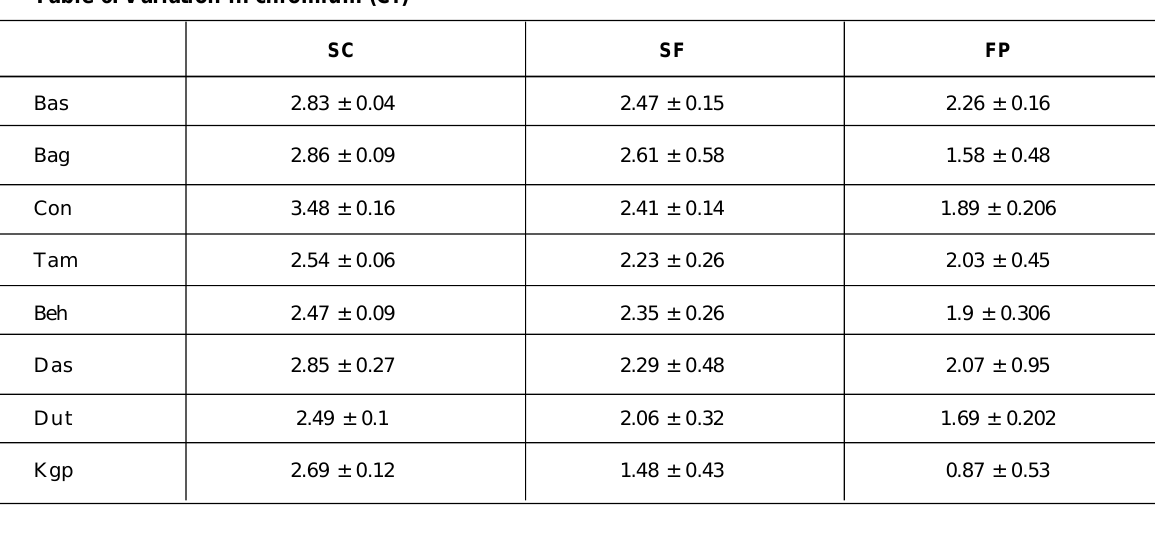
Table 6: Variation in chromium (Cr)